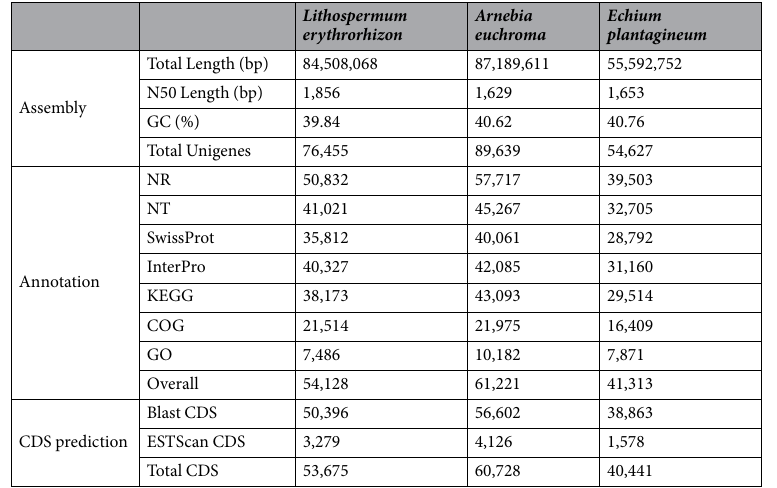
Table 1. Overview of transcriptome assembly, annotation and CDS